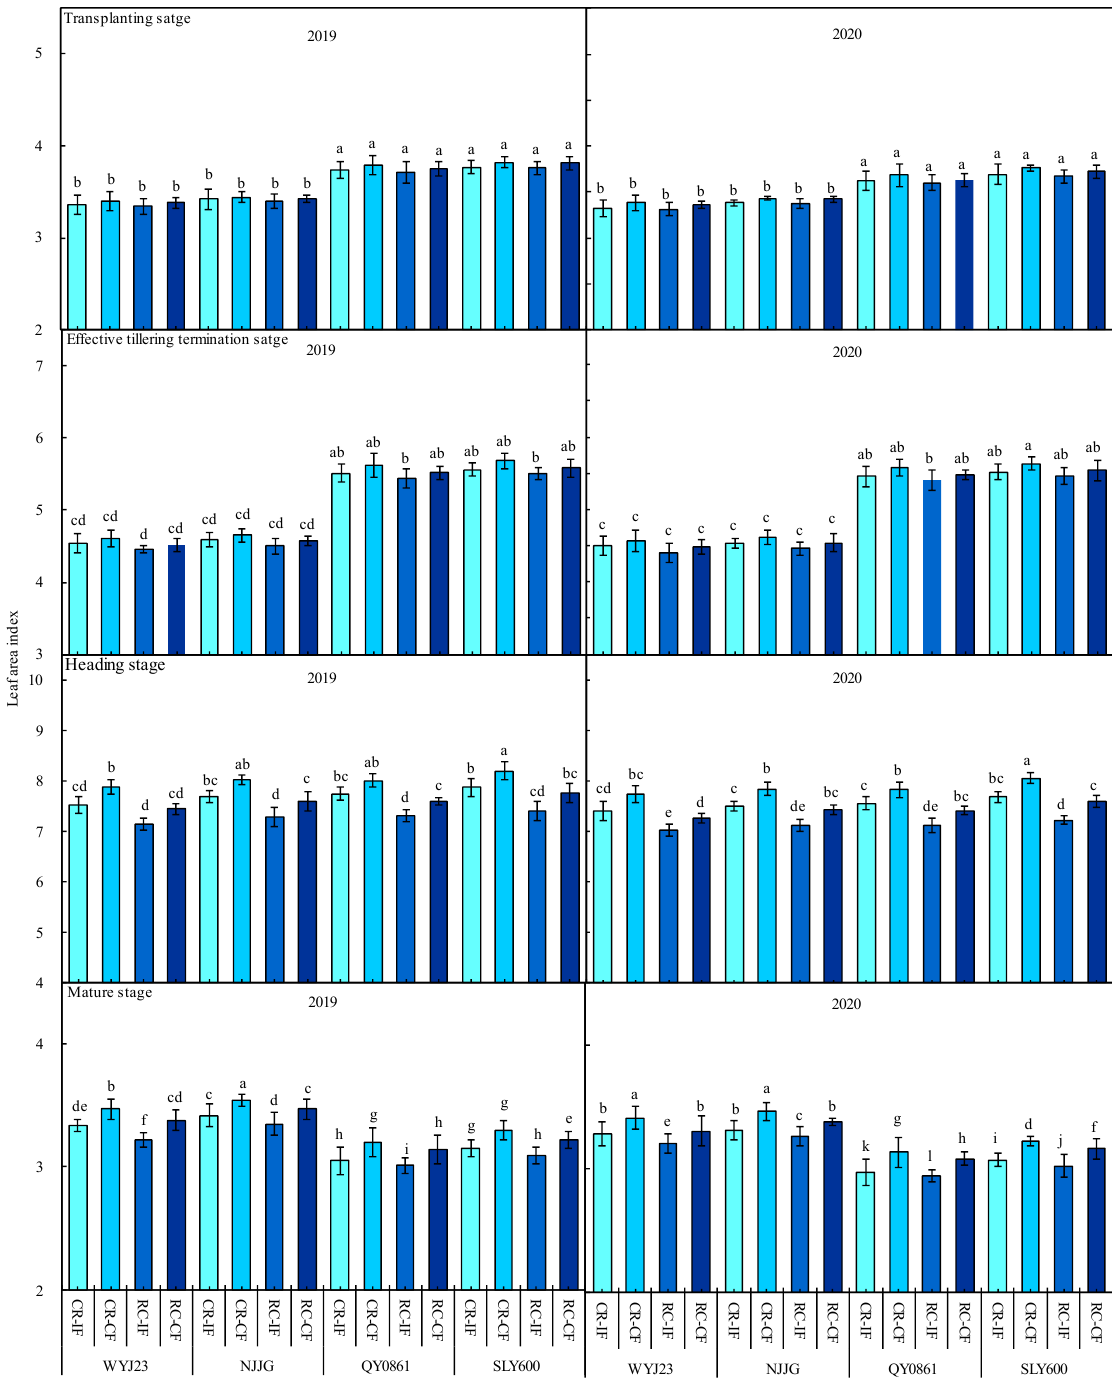
Figure 2. Leaf area indexes of different rice varieties under two types of fertilizer treatments. Different lowercase letters indicate significant differences among all treatments of four varieties in the same year at the 5% level according to LSD tests (0.05).